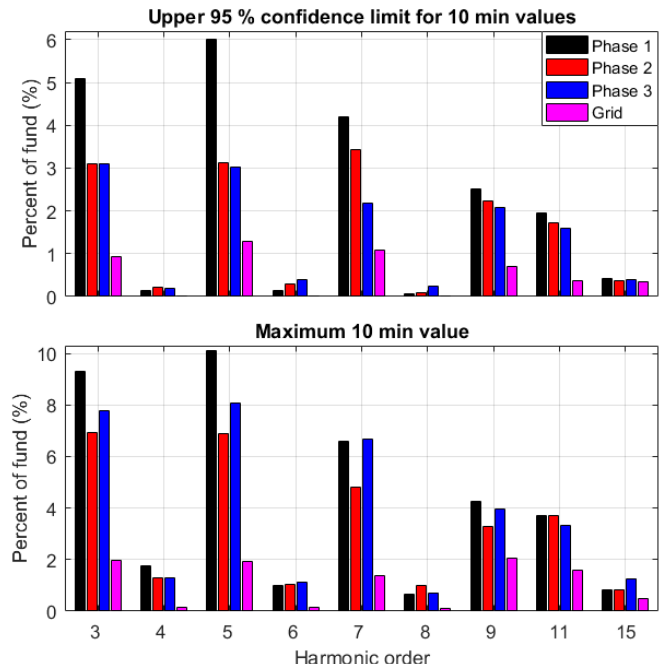
Figure 5. Individual harmonics of the voltage THD in Figure 4 where the left side is the individual harmonics at the end of the 1-cycle period at about 20 ms and the right side at about 80 ms. The 95% confidence limit for the 10 min values for the odd voltage harmonics 3rd to 11th and 15th and even voltage harmonics 4th to 8th can be seen in the upper part of Figure 6.